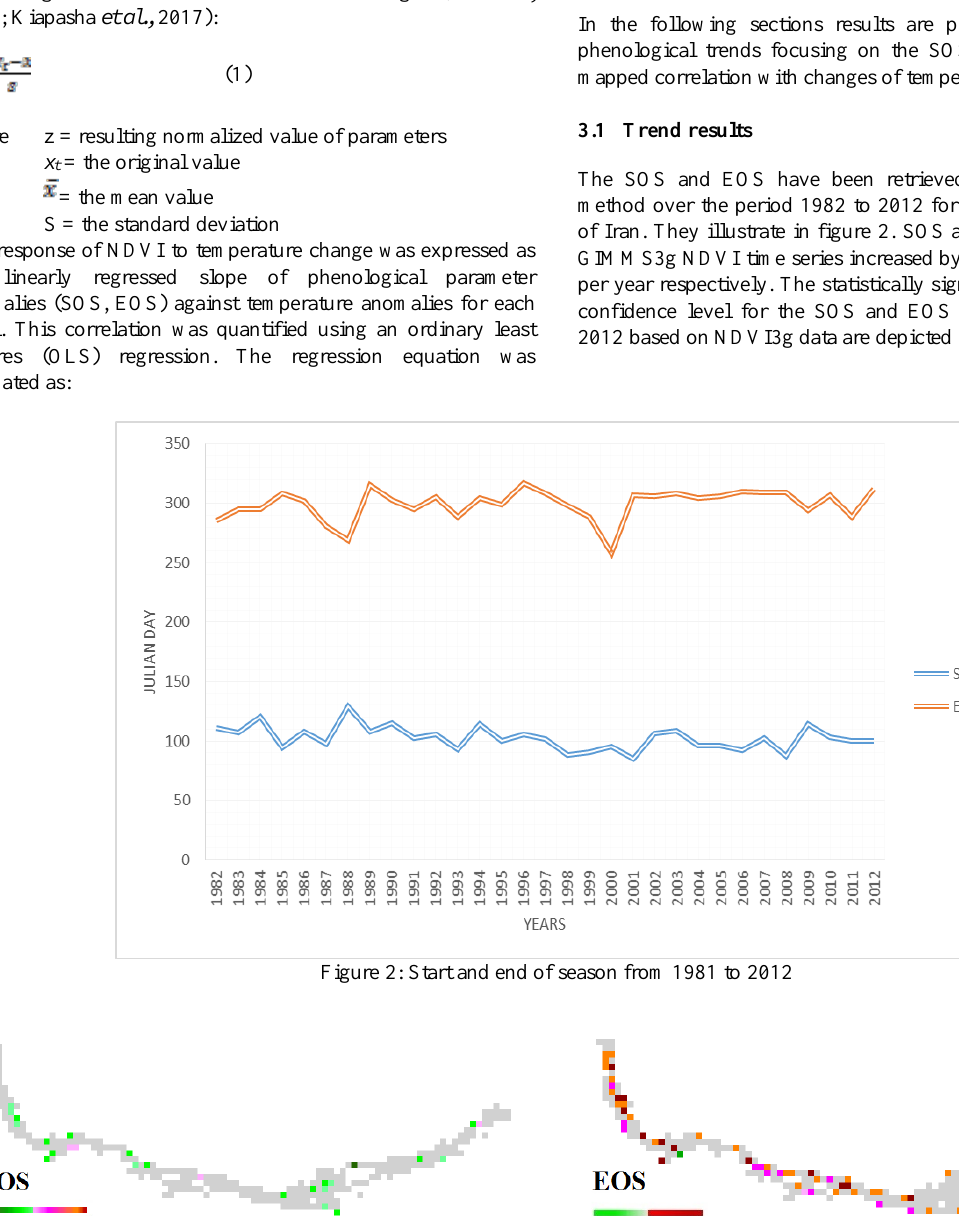
Figure 4: Significant trends at 90% confidence level using Mann- Kendall trend test in end of season date